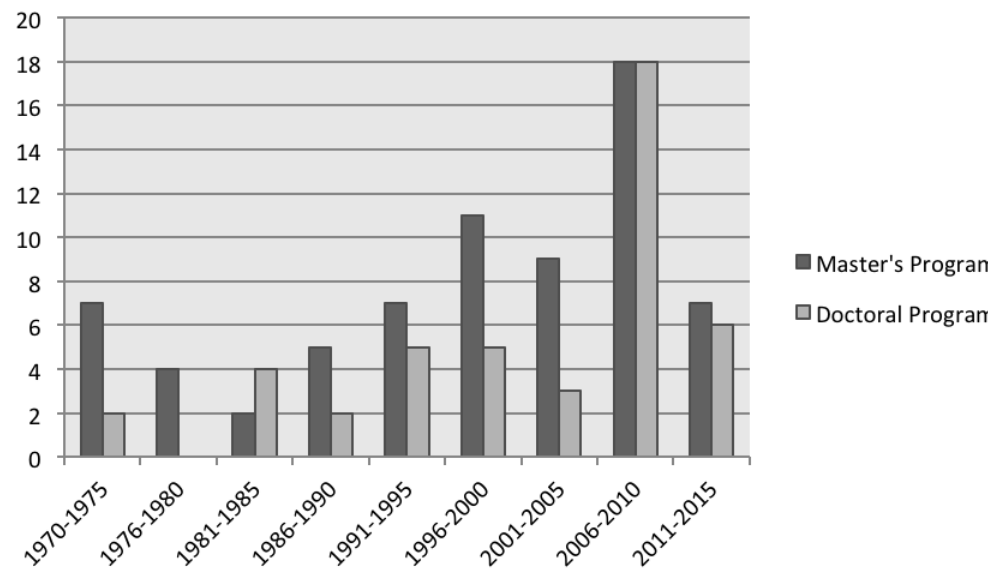
Figure 1 . Growth trend of Master’s and Doctoral programs in Brazil: